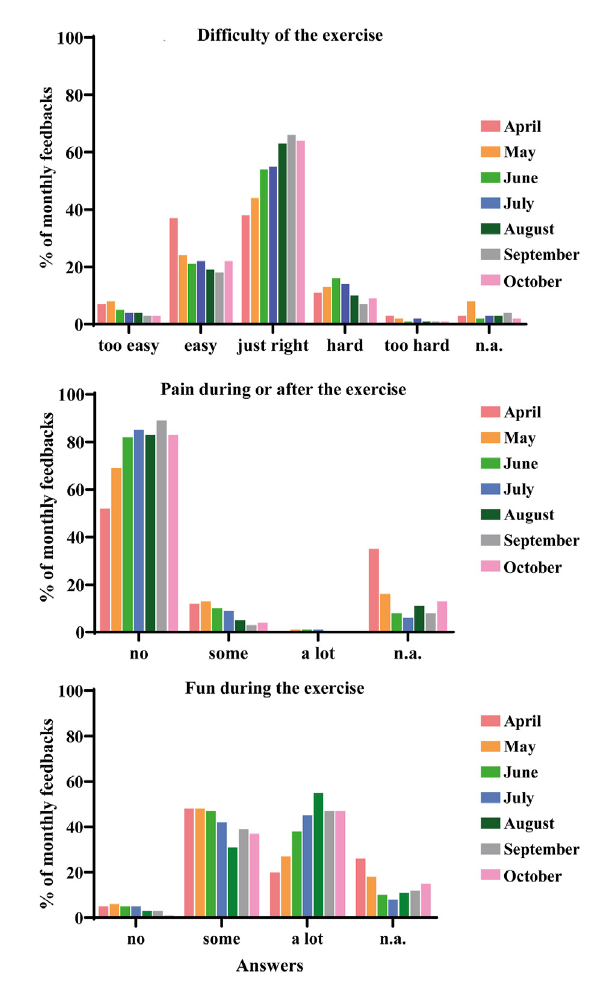
FIGURE 3 Monthly feedbacks on dif fi culty, pain, and fun levels by the cohort of patients in the seven-month period of orientation phase.